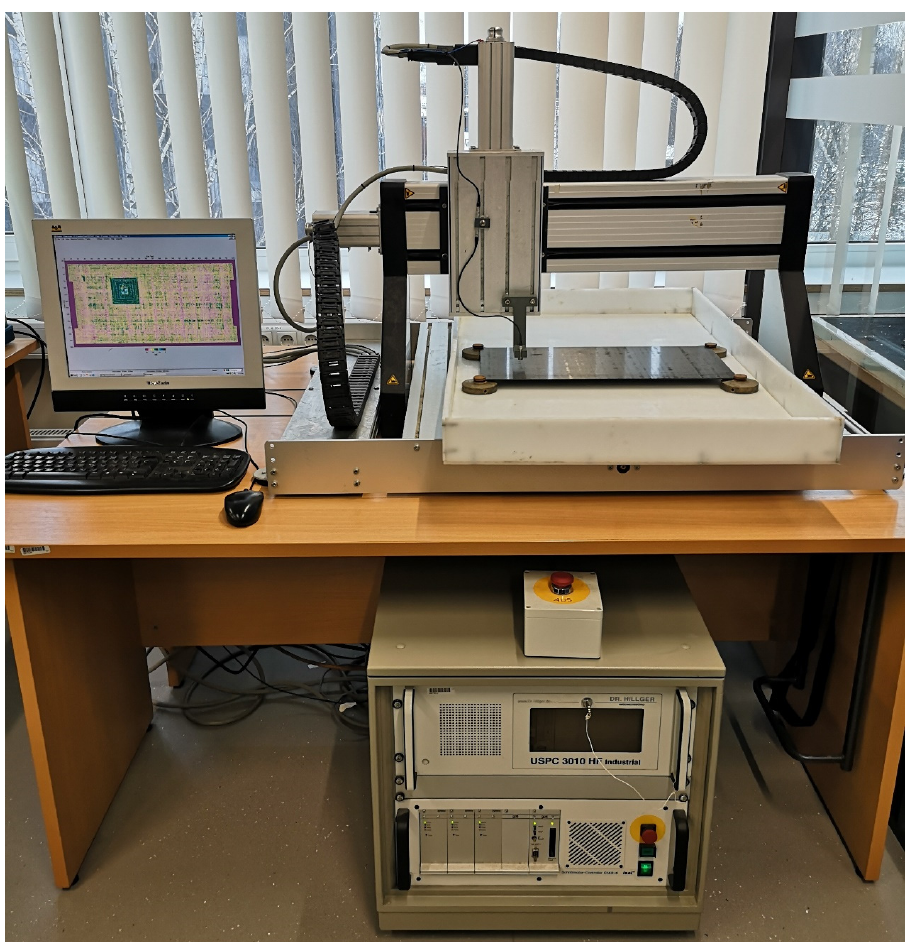
Figure 2. The ultrasonic experimental setup.